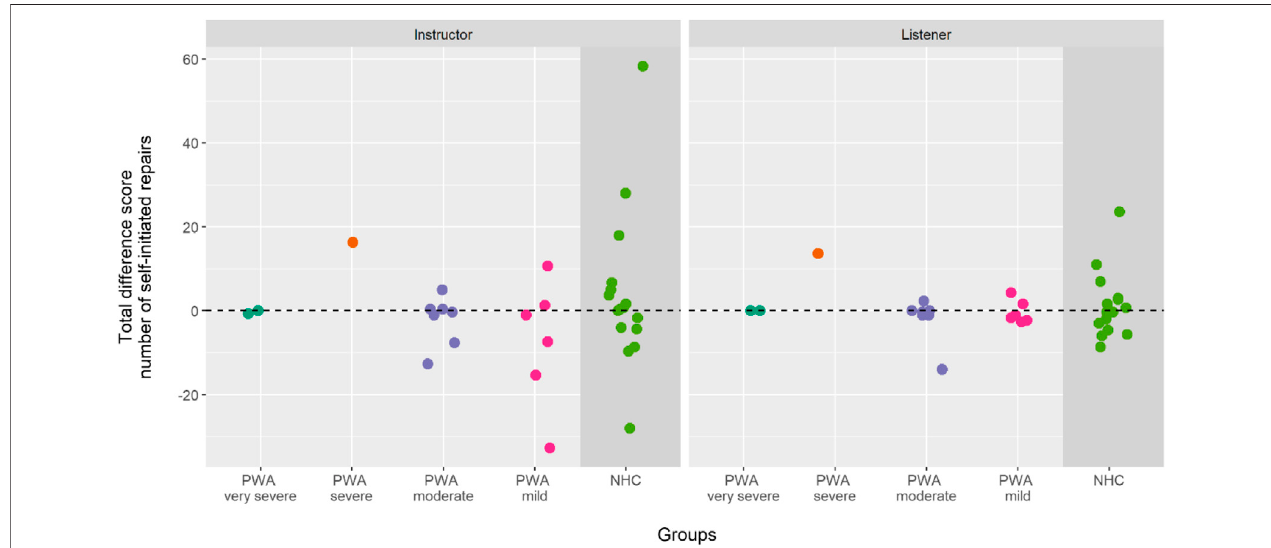
FIGURE8| PlotshowingindividualdatapointsforPWAfordifferencescorebetweenfamiliarandunfamiliarconditions,byrole,categorizedbyWABcategorization. Zero represents no change in self-initiated repairs between conditions, negative values indicate a smaller number of self-initiated repairs in the unfamiliar condition compared to the familiar